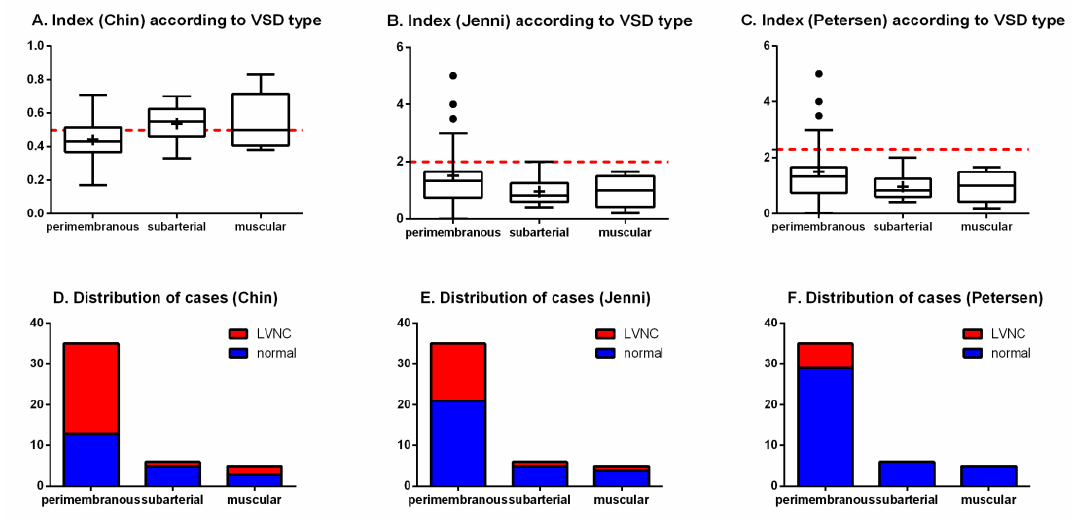
Figure 5. Indexes of left ventricular trabeculation according to VSD type (superior panels) and distribution of cases (inferior panels), as evaluated by Chin, Jenni, and Petersen methods, in. The red dotted lines represent the threshold for LVNC for each criterium. ( A ) index (hin) according to VSD type; ( B ) index (Jenni) accrding to VSD type; ( C ) index (Petersen) according to VSD type; ( D ) distribution of cases (Chin); ( E ) distribution of cases (Jenni); ( F ) distribution of cases